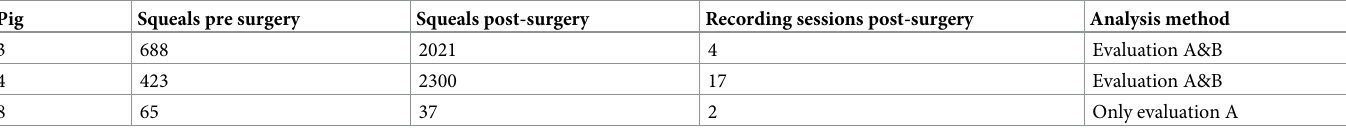
Table 2. Number of squeals included in analysis pre- and post-surgery, number of post-surgery recording sessions per pig and type of analysis performed for each pig. Pig Squeals pre